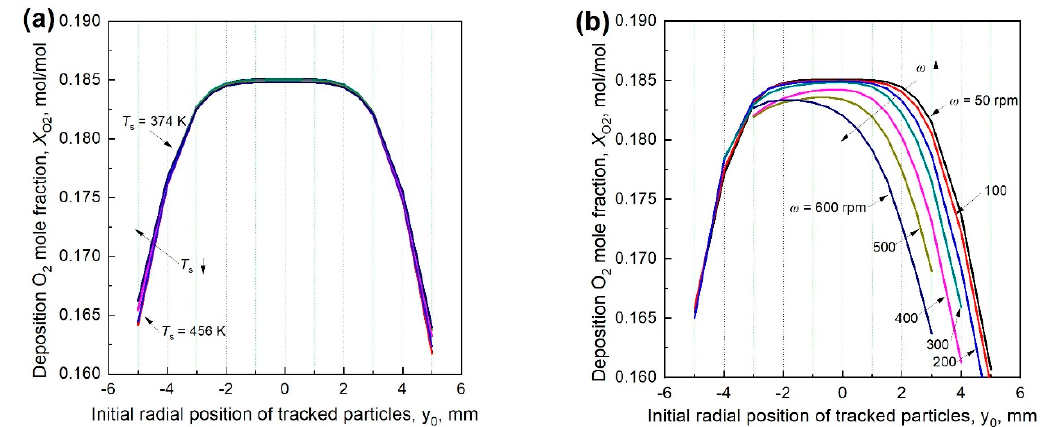
Figure 12. Averaged O 2 concentration around the tracked particles when the stagnation surface is ( a ) in stationary and ( b ) rotates at different speeds.